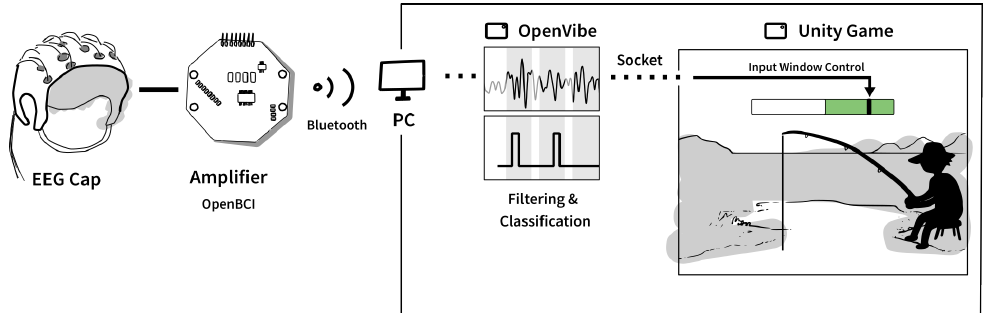
Figure 1. Data flow from the BCI cap to the fishing game developed in Unity. The BCI only controls the game when the black cursor is within the input window, marked by the green area on a bar displayed in the fishing